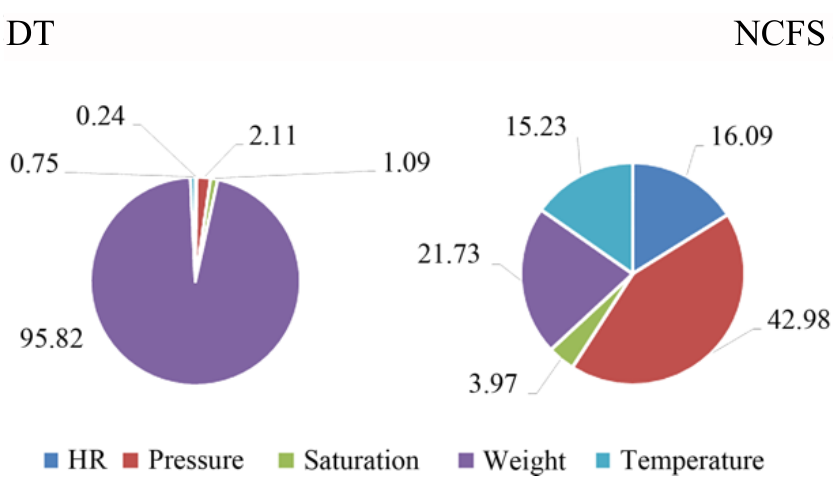
Figure 11. Percentage of importance of the health-related predictors for the classification of the users’ behavior and smart home profile.